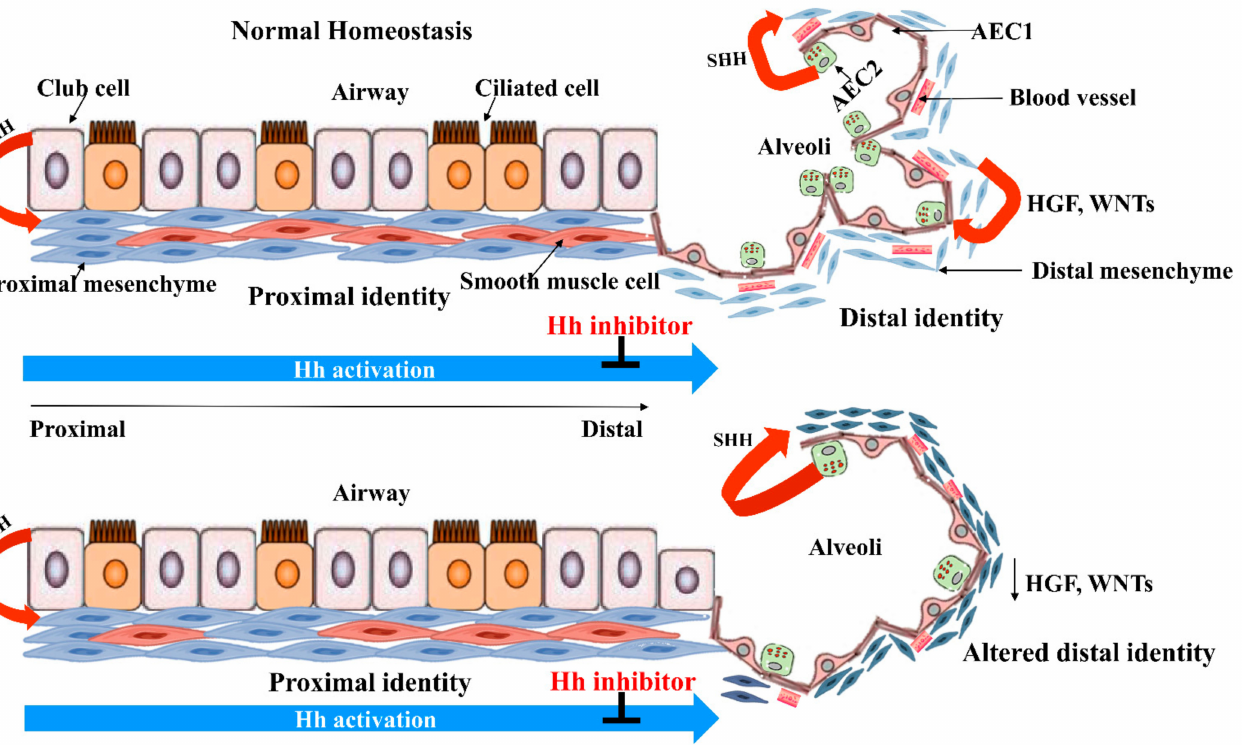
Figure 1. Asymmetric hedgehog activation model that maintains distinct compartmental